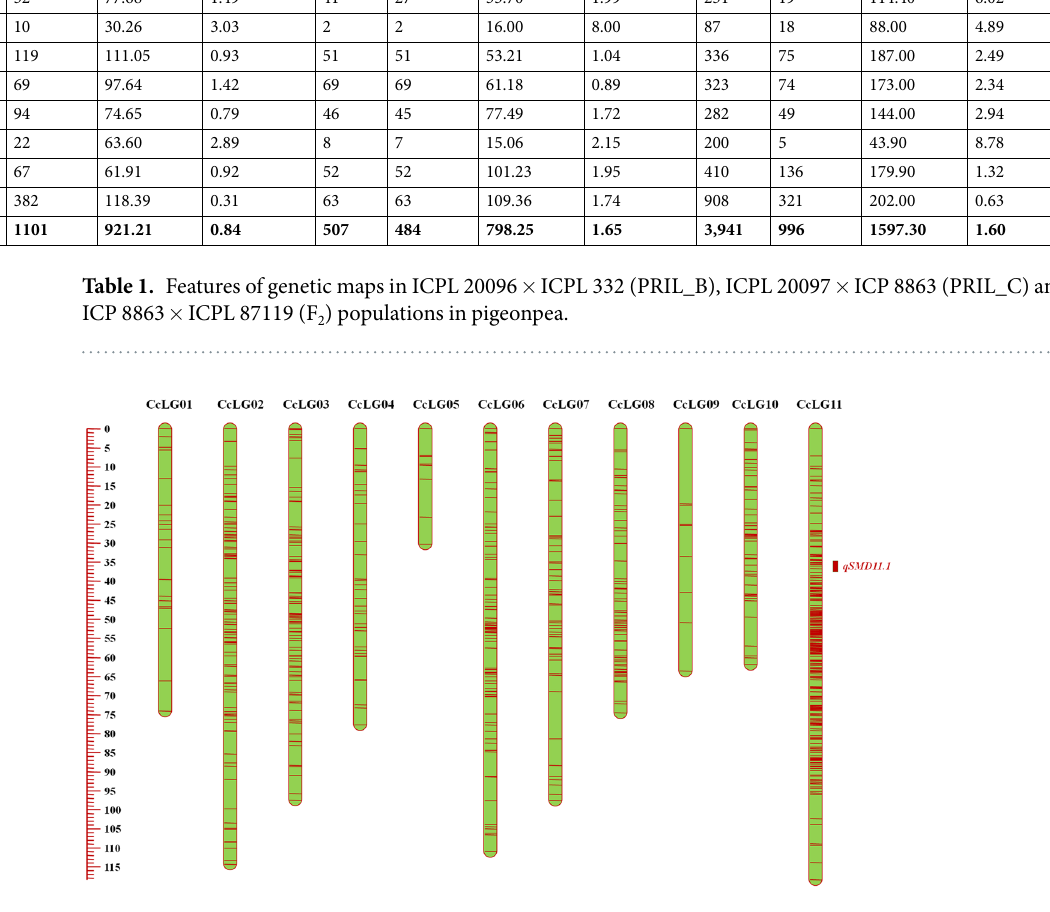
Figure 3. Genetic and QTL map comprising 1,101 SNPs and spanning 921.21 cM in ICPL 20096 × ICPL 332 (PRIL_B) population in pigeonpea. The scale on left side represents map distance in cM. The eleven linkage groups are shown as vertical bars and each horizontal line on the bar represent single SNP marker. Aggregation on horizontal lines indicate higher marker density on that particular linkage group. The single, consistent QTL ( qSMD11.1 ) identified for SMD resistance on CcLG11 is shown by coloured